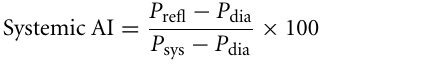
of individual cardiac cycles (gray lines) over 15s, the composite (i.e., mean waveform; black line), and the location of the waveform